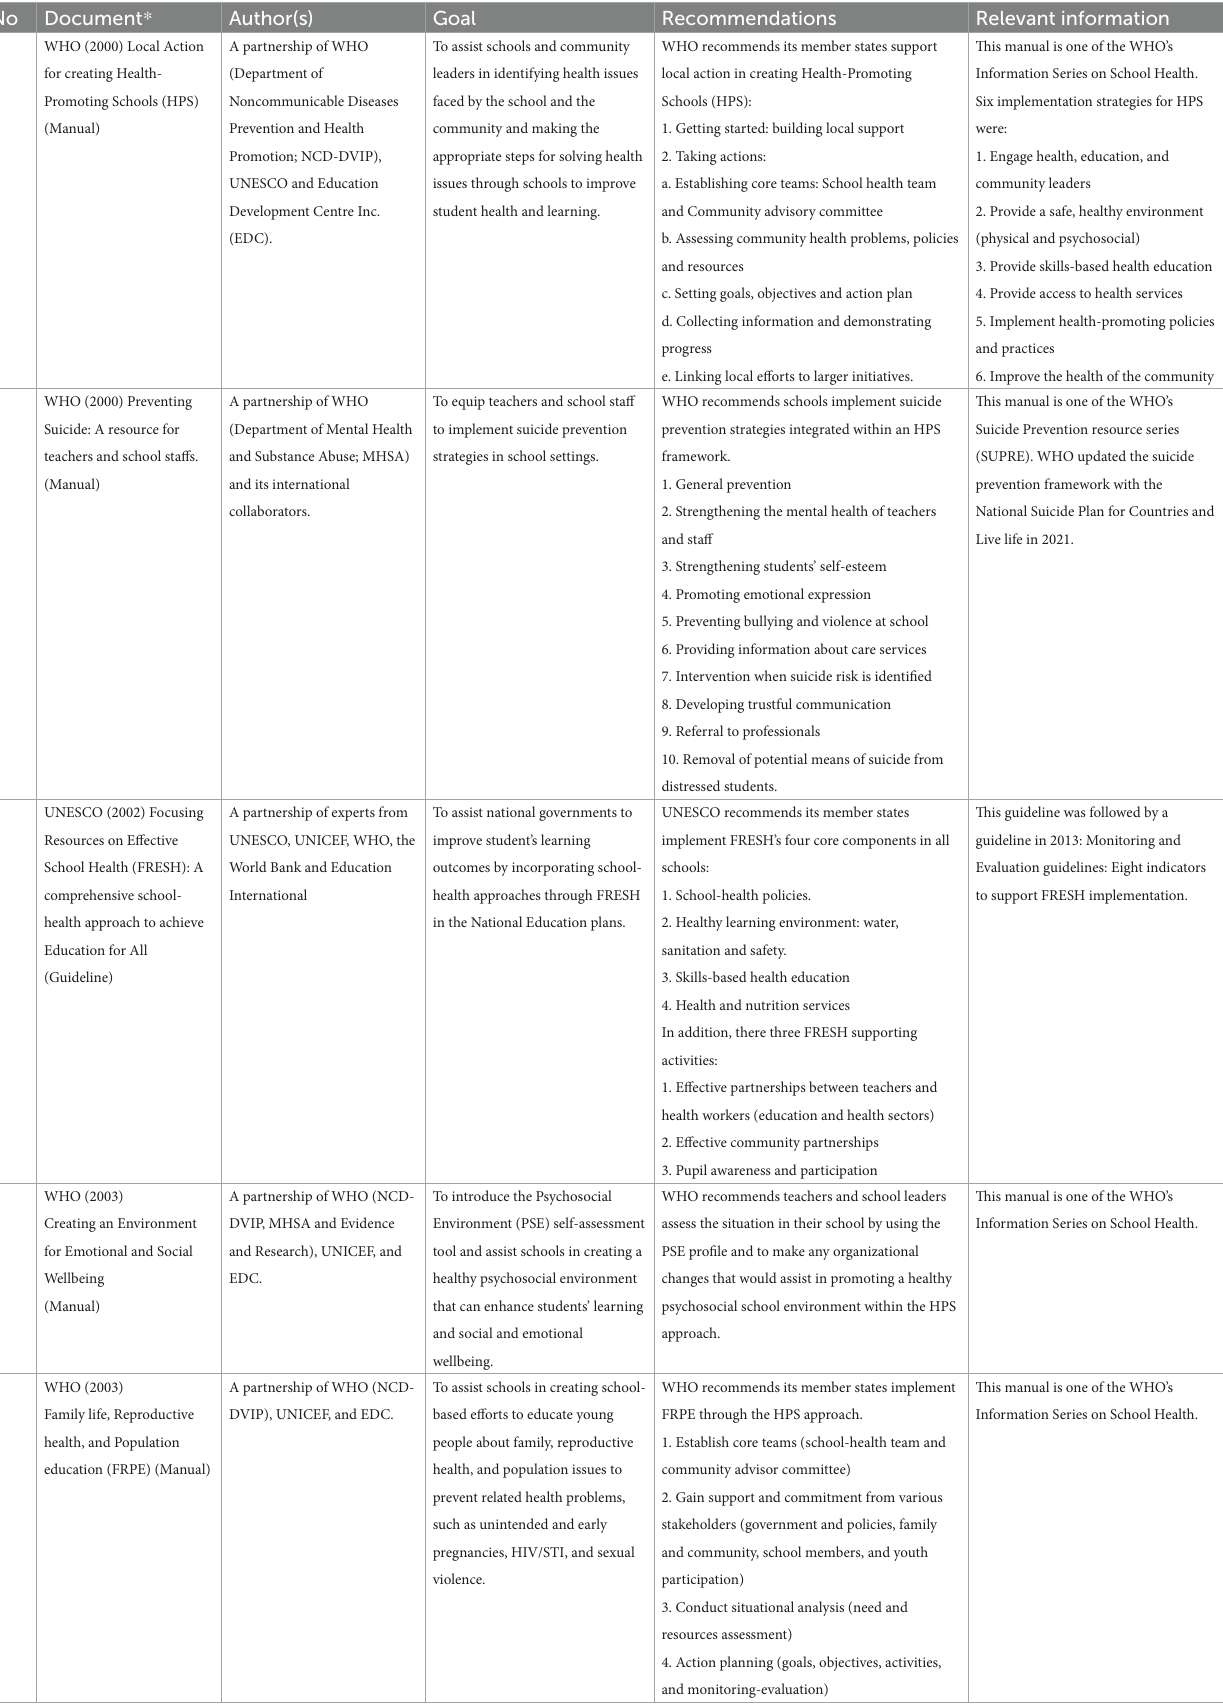
TABLE 1 Summary of relevant findings from the included UN agencies’ policy documents on school-based mental health